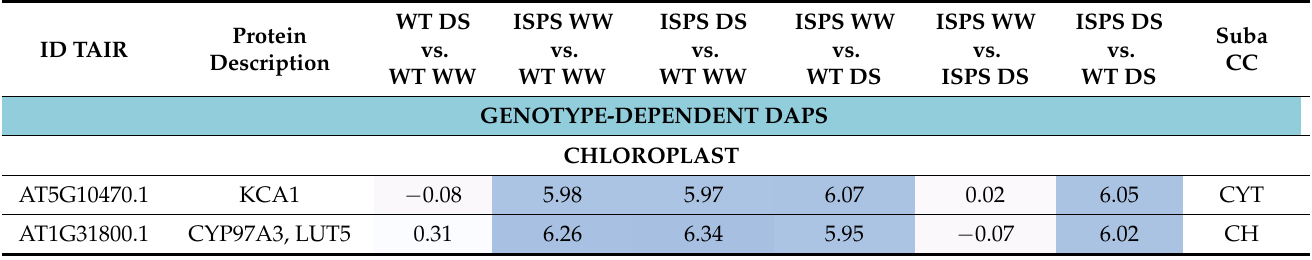
Table 1. List of relevant differentially abundant proteins (DAPs) dependent on genotype (G), treat- ment (T), and interaction (I) divided according to their subcellular localization (Suba CC) and function (chloroplast-related functions, endomembrane trafficking, cellular signaling, osmoprotection, redox homeostasis, and defense). Blue and red boxes show upregulated and downregulated proteins, respectively, in the comparisons